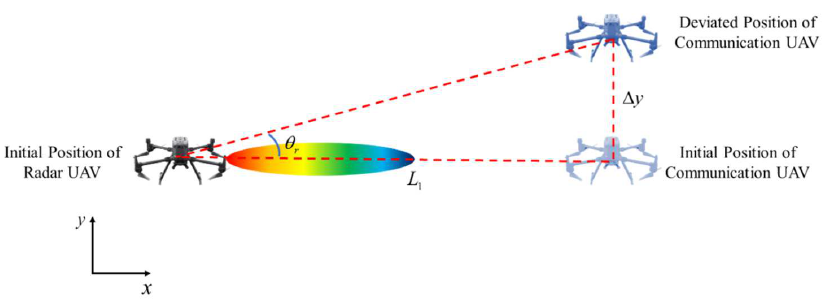
Figure 2. Geometric relationship between communication UAV and radar UAV with position error.